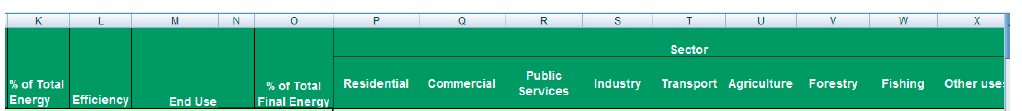
Figure 8. Distribution of the consumption on types of users.